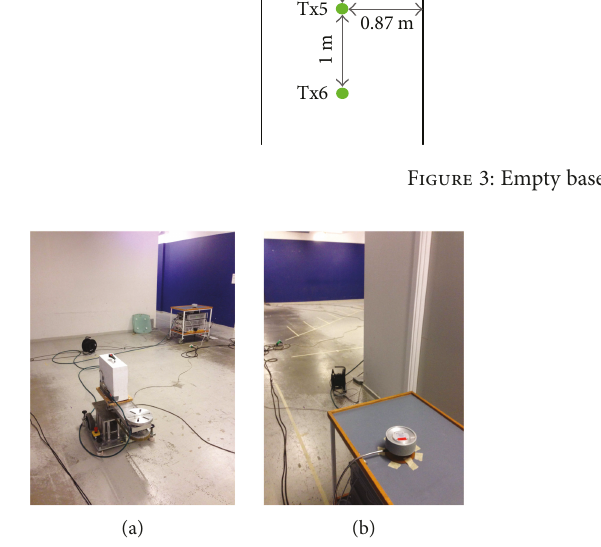
Figure 4: Photograph of the empty basement scenario: Rx view for Tx position 5 in the LOS scenario (a) and Tx view for Tx position 6 in the non-LOS scenario (b).